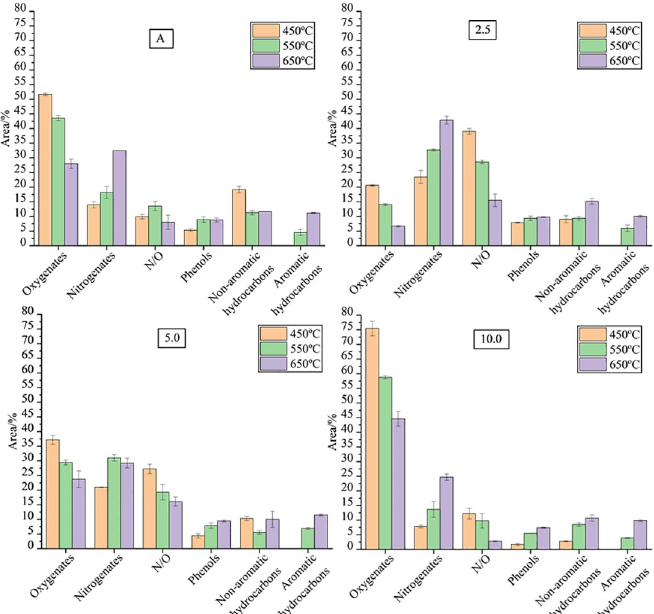
Fig 4. Yield (% area) of volatile compounds formed by pyrolysis of S . platensis at 450, 550 and 650 ˚C a) A b) M2.5 c) M5 d)